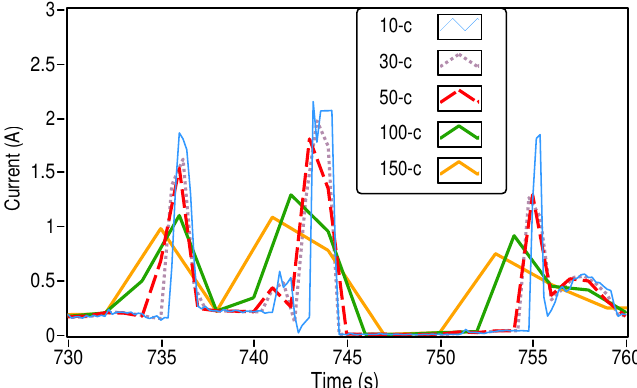
Figure 8. The 17th harmonic current measured over 10 cycles and aggregated over 30, 50, 100 and 150